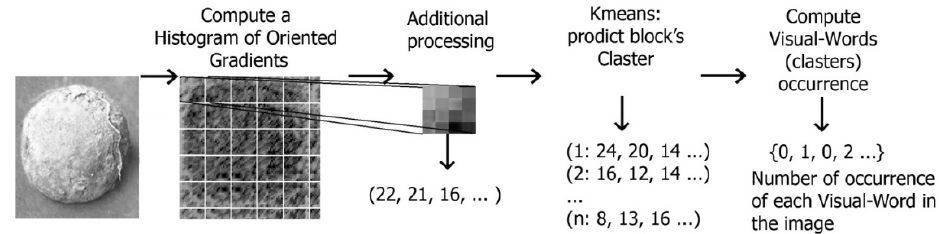
Figure 10. Steps to create Visual-Words.